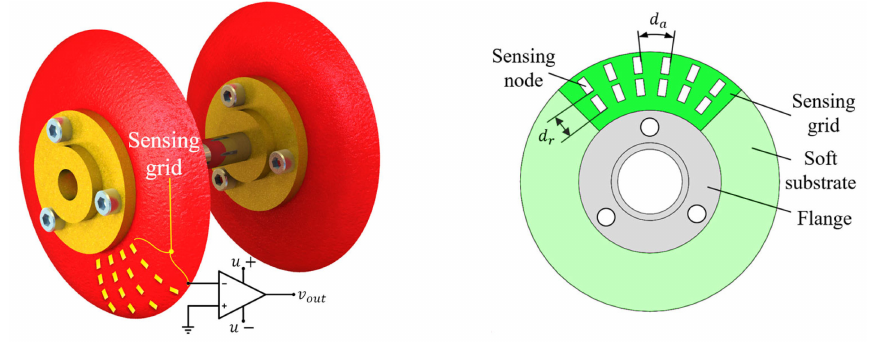
Figure 2. Schematic diagram of the structure of the sensing cup ( left ) and a prototype illustration ( right